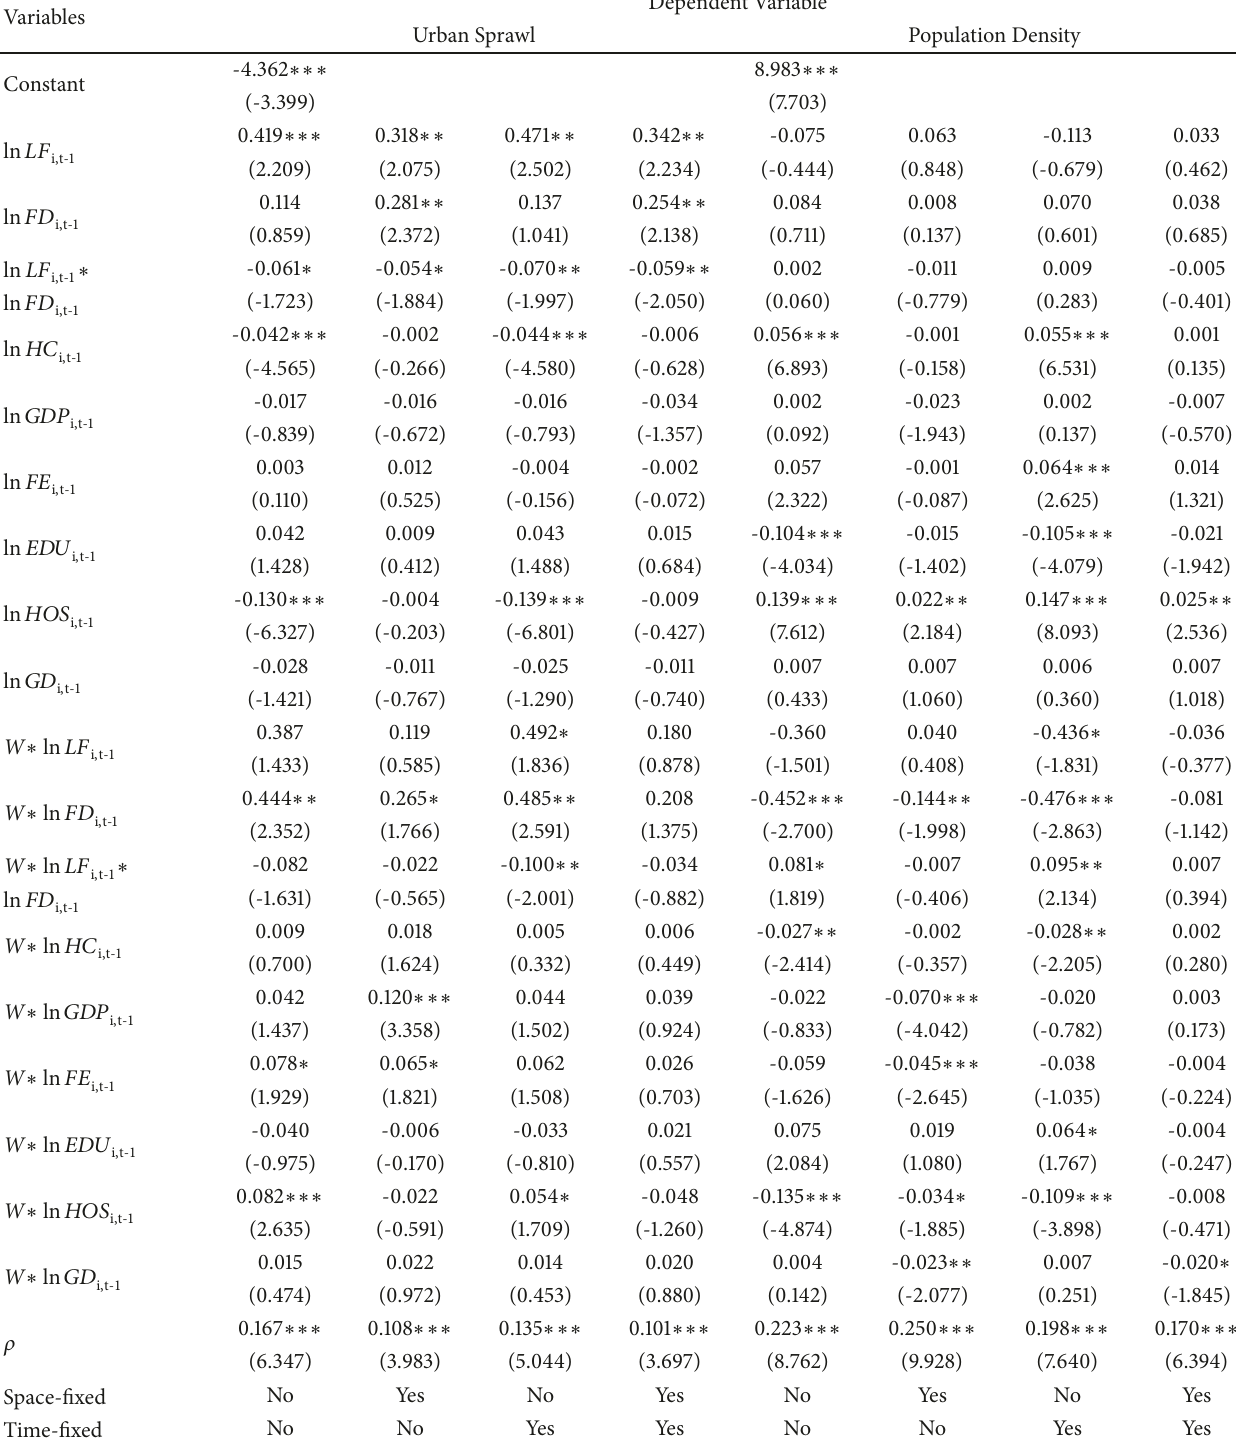
Table 3: The results for the whole